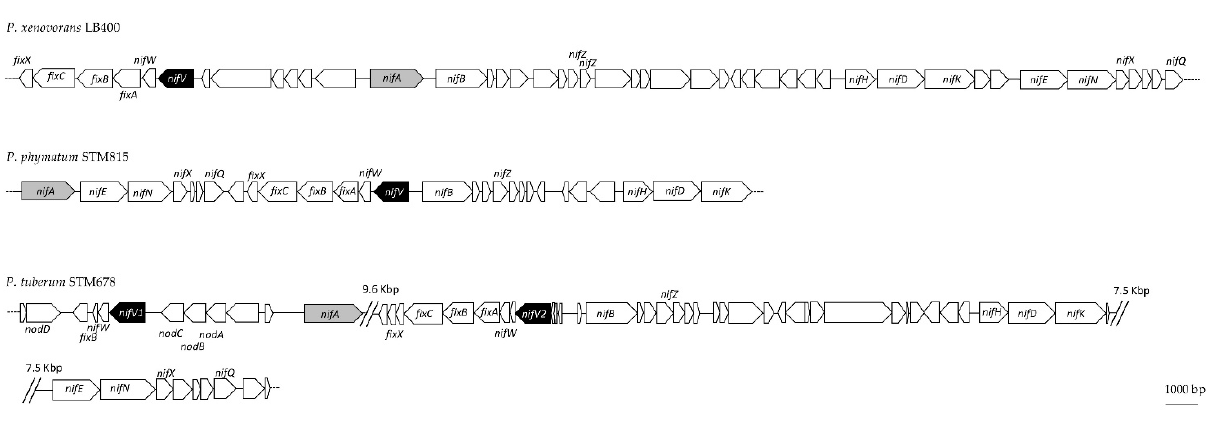
Figure 2. Genomic location of nifV in representative Paraburkholderia strains. P. xenovorans LB400, P. phymatum STM815 and P. tuberum STM678 as representatives of the groups free-living Paraburkholderia , Paraburkholderia nodulating mimosoids and Paraburkholderia nodulating papilionoids, respectively. The nifV gene is highlighted in black and the transcriptional regulator nifA in grey.